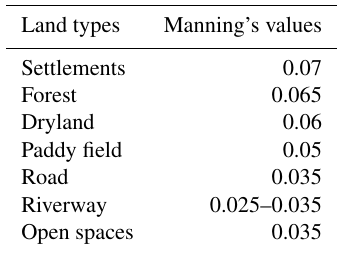
Table 2. The Manning’s values related to the land cover types over the study